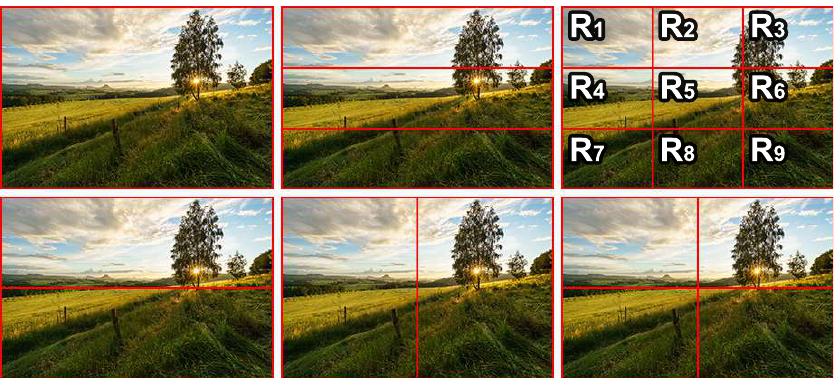
Figure 5. Illustrations of region splits. First row: whole scene, regions split by landscape rule and rule of thirds respectively. Second row: regions split by symmetry